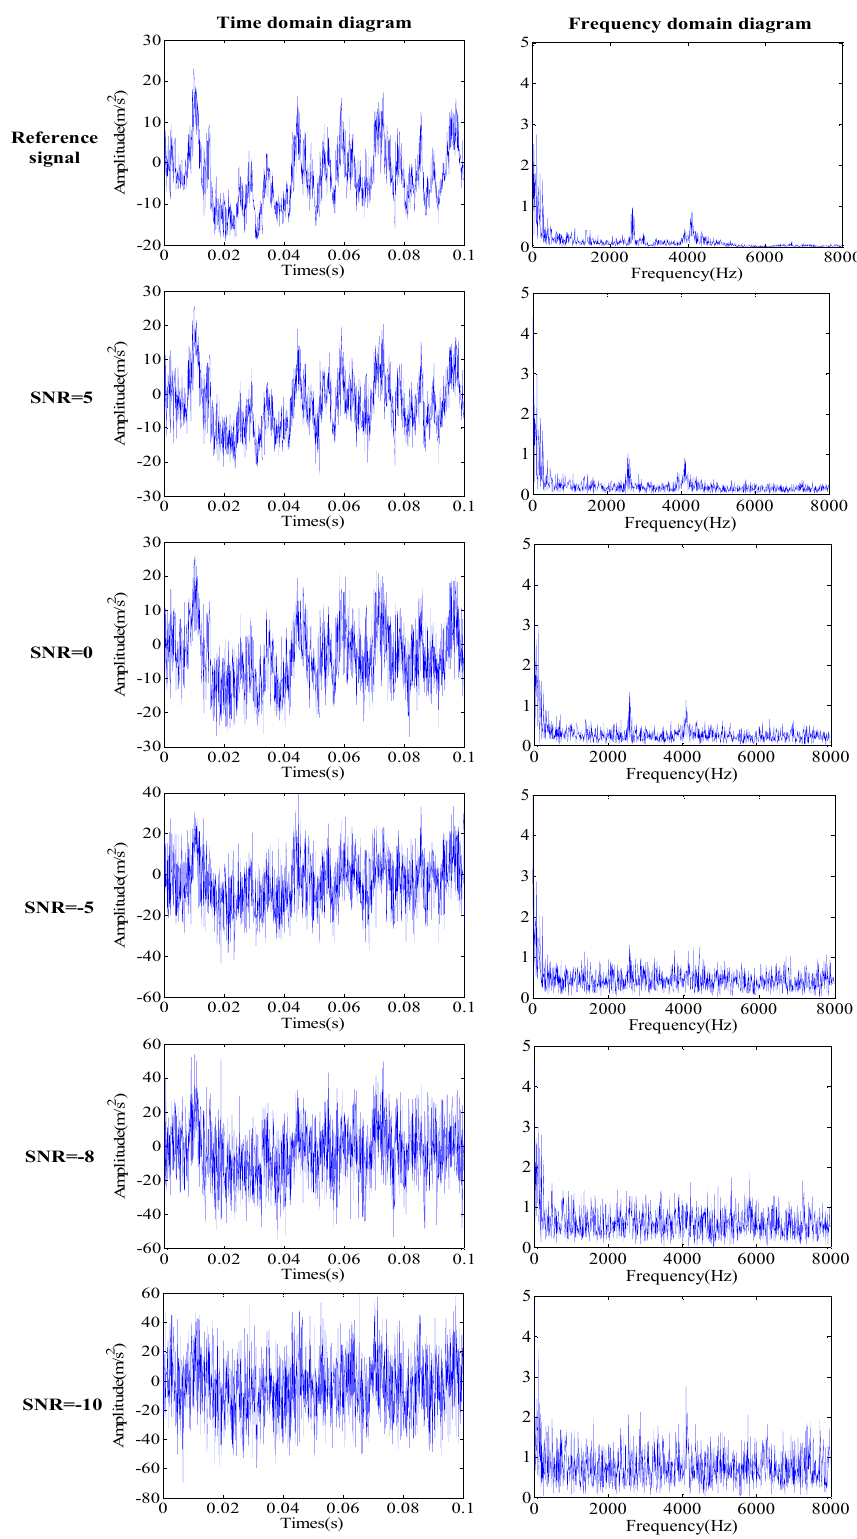
Figure 6. Time domain and frequency domain diagrams of different noise signals.